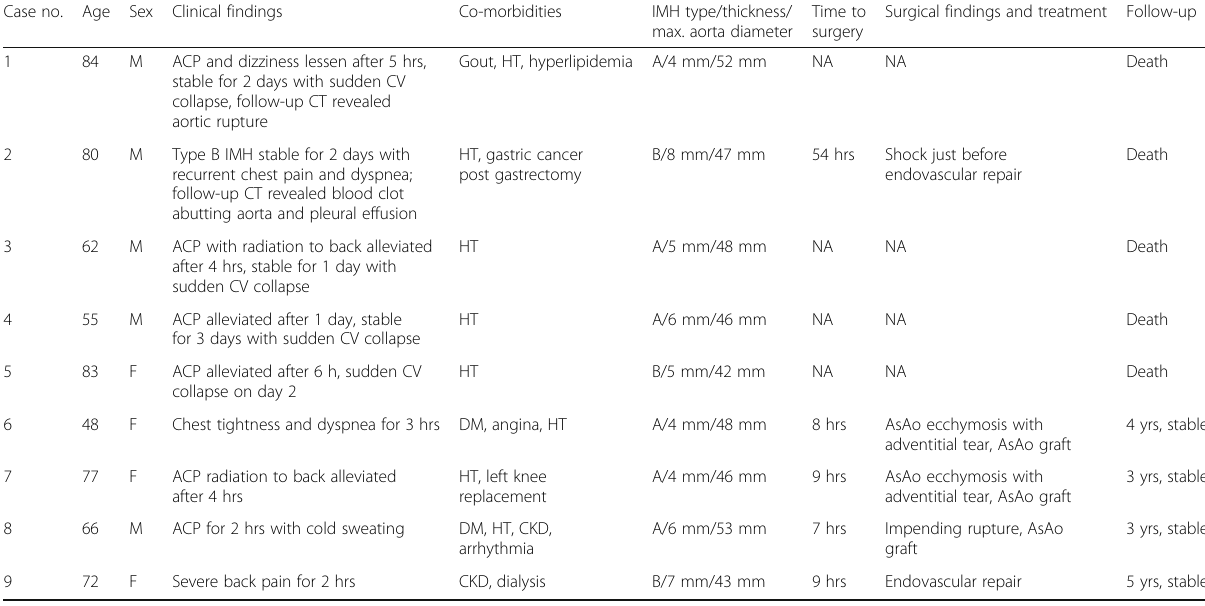
Table 1 Summary of 9 patients with aortic intramural hematoma (IMH) and broken-crescent sign on chest CT Case no. Age Sex Clinical findings Co-morbidities